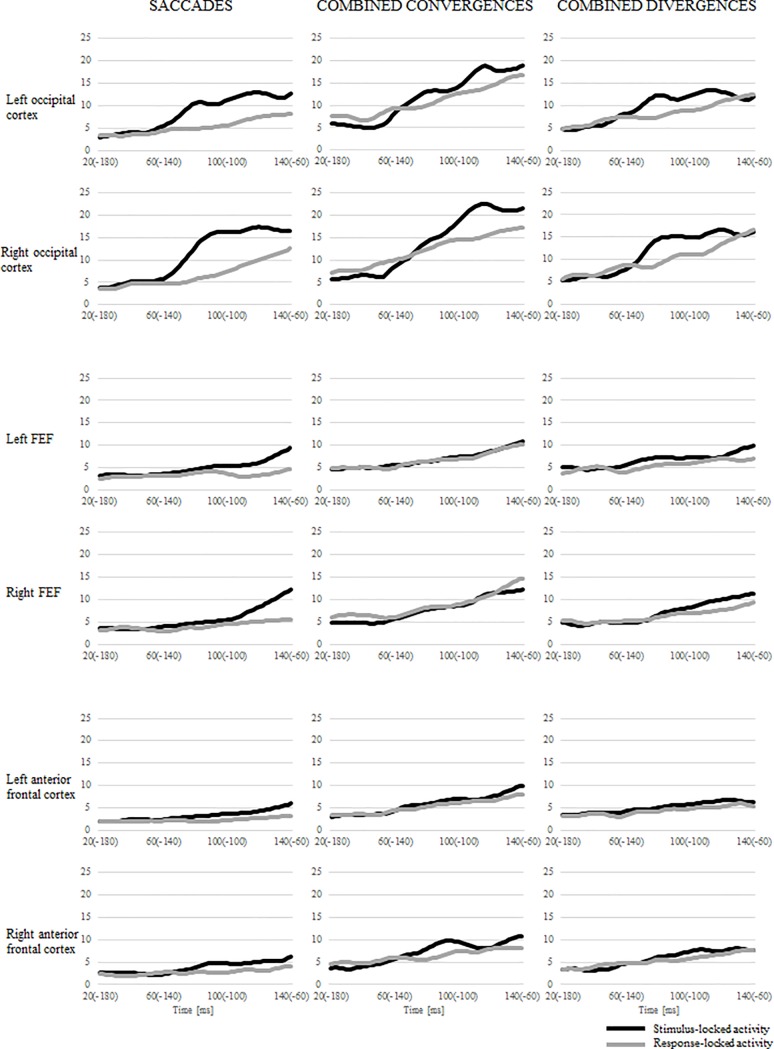
Source waveforms comparing stimulus-locked and response-locked activities in each regional source for saccades, combined convergences and combined divergences.